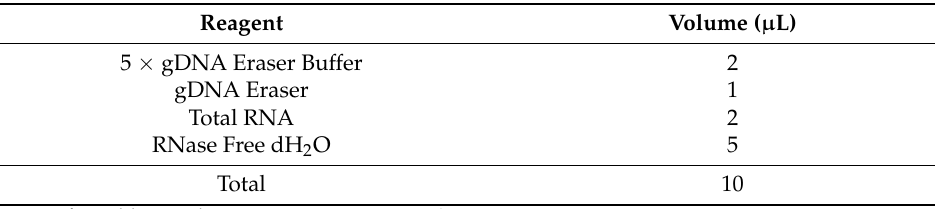
Table 4. Genomic DNA removal reaction system.